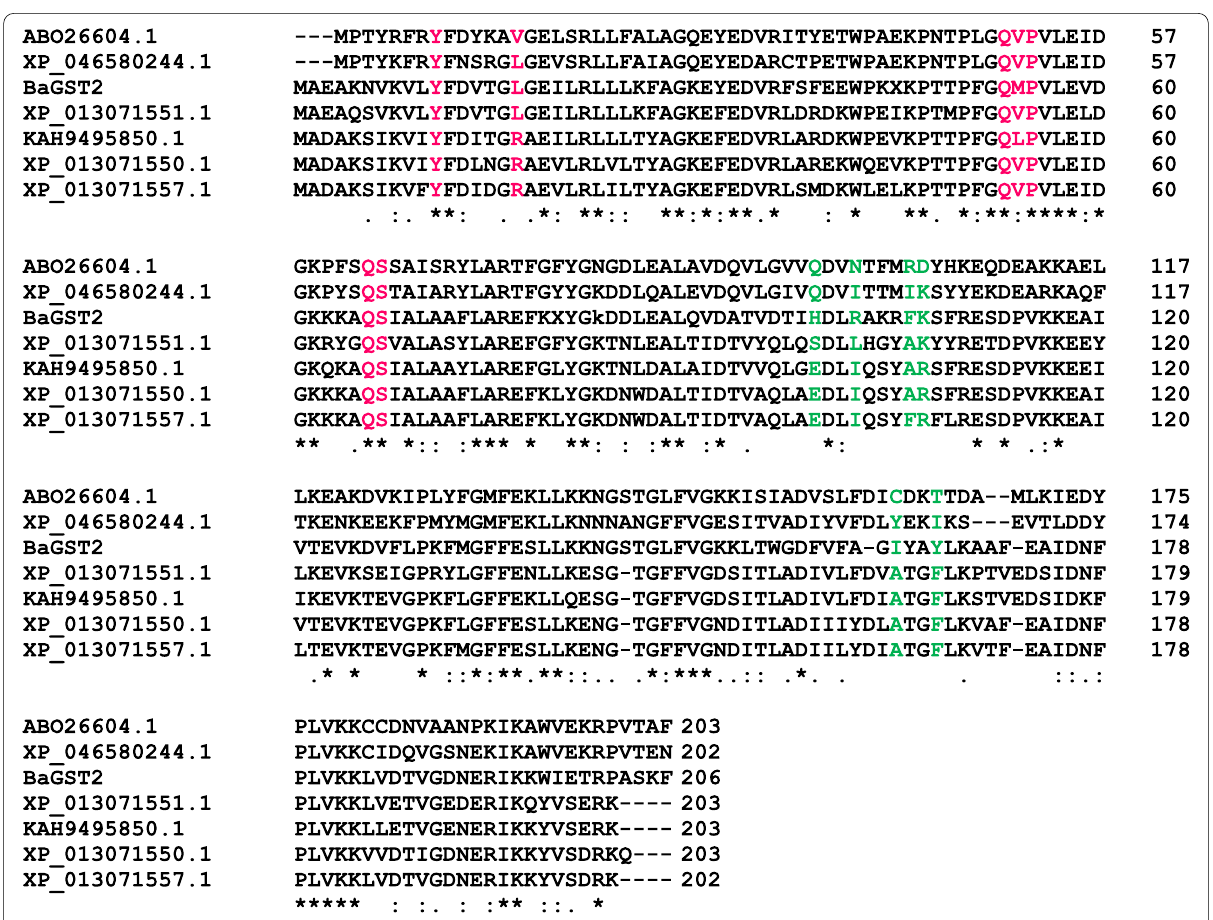
Fig. 5 Multiple alignment of BaGST2 sequence with GST sequences from freshwater snails. The alignment was created using Clustal Omega multiple sequence alignment program. ( * ) indicates identical residues in all sequences, while ( : ) indicates the highly positive residues and ( . ) for moderately positive ones. Unidentified gaps marked by hyphens are introduced for better alignment. The conserved G‑site residues are shown in red, and the substrate binding pockets (H‑site) are shown in